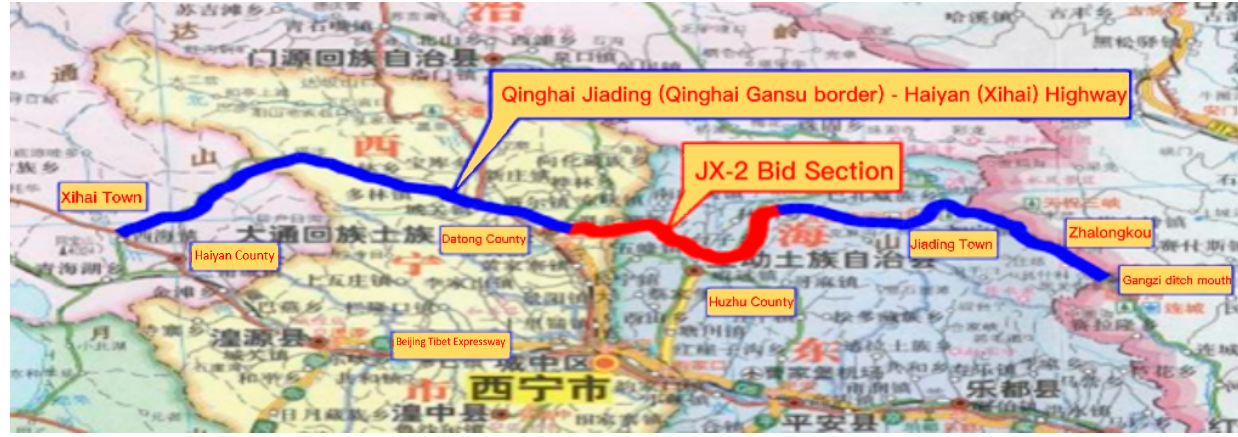
Figure 1. Qinghai Jiading–Haiyan Highway.